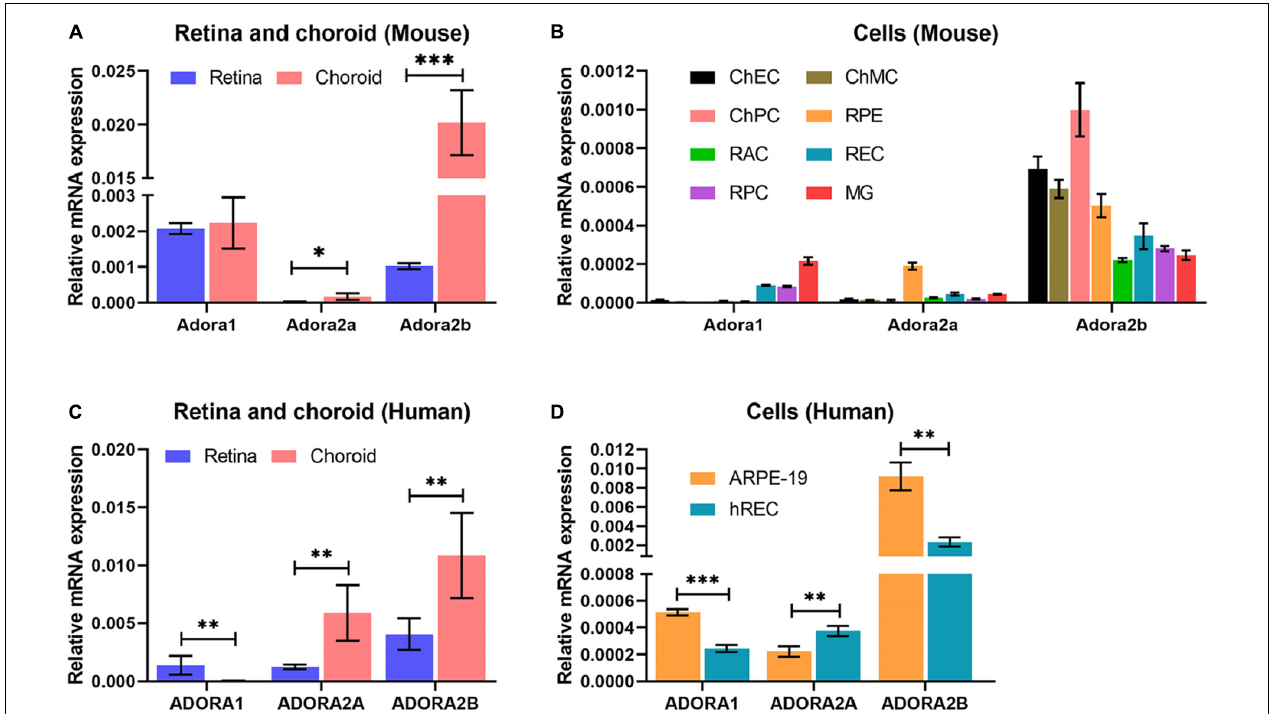
FIGURE 1 | Adenosine receptor expression in ocular cells and tissues. Expression of adenosine receptors (AR), A 1 (Adora1), A 2 A (Adora2a), A 2 B (Adora2b), and A 3 (Adora3) in murine ocular tissues (A) and cells (B) prepared from 2-month-old mice (tissues) and 1-month-old mice (cells) and human ocular tissues (C) and cells (D) were determined by qPCR. These included retinal and choroid/RPE tissues (A) and retinal microglia (MG), retinal astrocytes (RAC), choroidal endothelial cells (ChEC), choroidal pericytes (ChPC), choroidal melanocytes (ChMC), retinal endothelial cells (REC), retinal pericytes (RPC), and retinal pigment epithelium (RPE) cells. Please note highest A 1 expression in microglia, A 2 A expression in RPE cells, and A 2 B in ChEC, ChPC, ChMC, and RPE cells. The A 3 level was very low in all cells examined. The retina and choroid/RPE tissues showed higher A1 and A2B. A similar expression pattern was noted in human tissues (C) , and REC and RPE (ARPE19) cells. (* P < 0.05, ** P < 0.01, *** P <